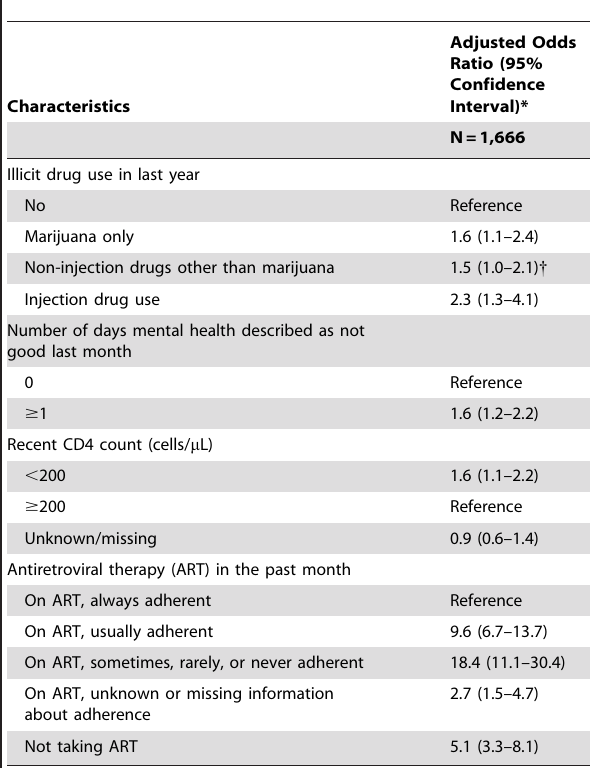
Table 2. Multivariable analysis of factors associated with nonadherence to primary prophylaxis against Pneumocystis jirovecii pneumonia (PCP) – Supplement to HIV/AIDS Surveillance (SHAS) project,